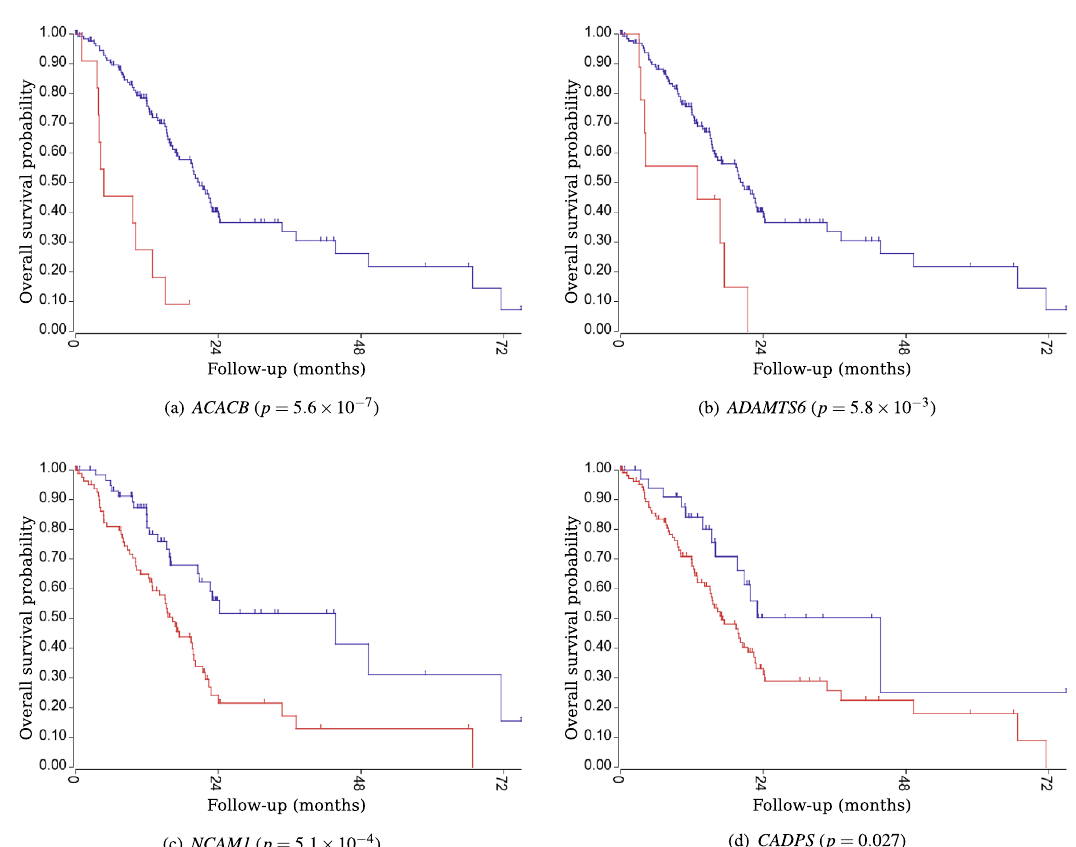
Figure 4. Kaplan–Meier plots of overall survival for the top three genes in Task 1. The top three genes were ACACB , ADAMTS6 , and NCAM1 at N = 10 , and ACACB , ADAMTS6 , and CADPS at N = 50 . These genes were significant prognosis